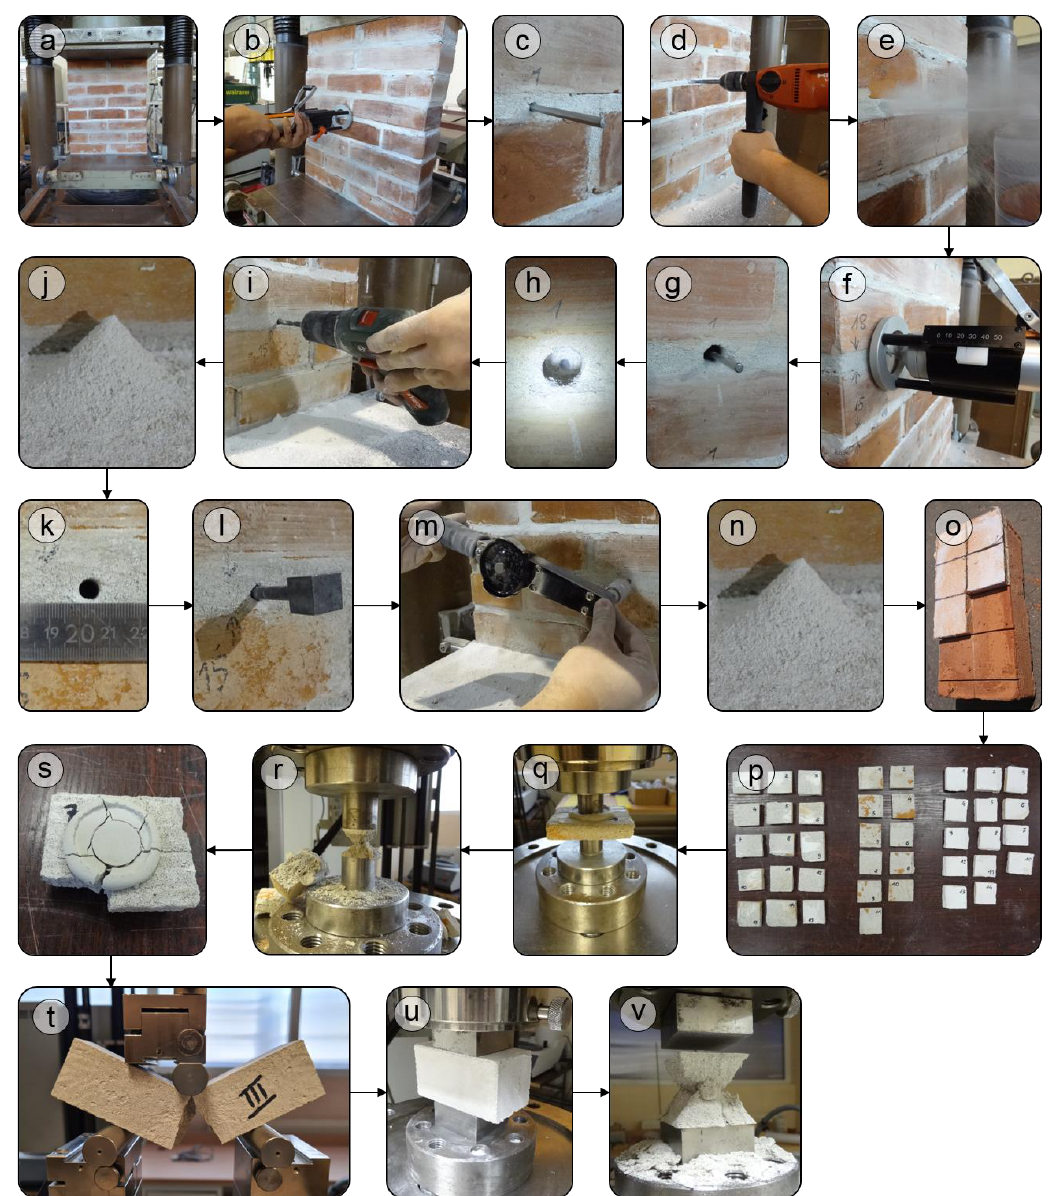
Figure 6. The sequence of the tests: ( a ) the immobilisation of the prism with the force generating the pressure of 0.15 MPa; ( b ) the performance of the PT test at the outer surface; ( c ) the verification of the correctness of the needle settlement in the middle of the joint thickness and its horizontal position; ( d ) the immersion drill hole with the diameter of 12 mm at the depth of 4 cm; ( e ) the removal of dust with compressed air; ( f ) the performance of the downhole measurements during PT test; ( g ) and ( h ) the verification of the correctness of the needle settlement as in “c”; ( i ) drilling at the depth of 5 cm of the pilot hole with the diameter of 7 mm; ( j ) the verification of the drill cuttings for the purpose of determining whether the brick layer remained intact or not; ( k ) the measurement of the diameter to ensure whether the probe teeth are anchored correctly or not; ( l ) sticking the probe in; ( m ) the performance of the TPT test; ( n ) the verification of the drill cuttings as in “j”; ( o ) when the PT and the DPT tests are completed, dismantling the brick prism and extracting the specimens for the DPT tests; ( p ) levelling the specimen surface for the DPT tests; ( q ) the DPT test; ( r ) the destruction form of the DPT specimen; ( s ) the crack pattern during destruction as the assessment of the lack of the eccentricity of the compressing force; ( t ) the performance of flexural tests on the referential specimens; ( u ) the performance of compression tests on the referential specimens; ( v ) the destruction form of the referential specimen during compression.